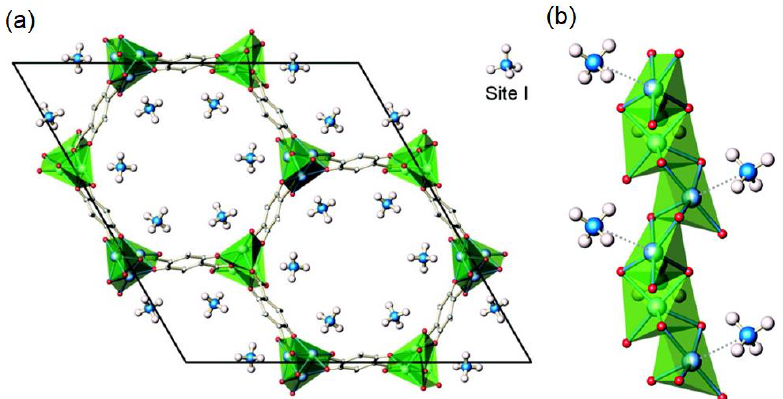
Figure 1. ( a ) M 2 (dhtp) (dhtp = 2,5-dihydroxyterephthalate) crystal unit cell with adsorbed methane molecules on open metal site I. The location of sites was determined by neutron diffraction. ( b ) Metal oxide pyramids, organic linkers, and methane molecules. Adapted with permission from [31].